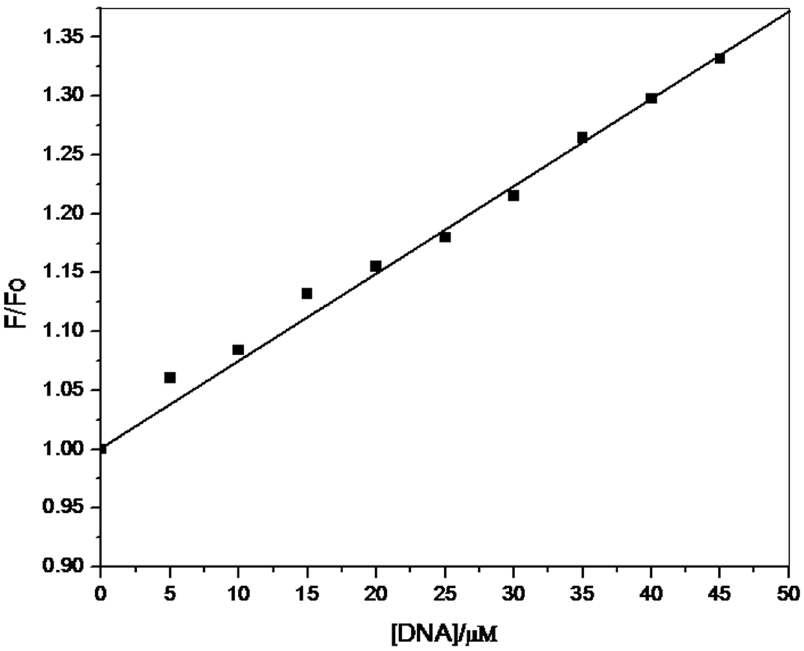
Figure 3. Stern-Volmer plot for interaction of 6MP with CT-DNA. The fluorescent intensity was found to be directly proportional to DNA concentration. Binding constant of 7.8 6 10 3 M 2 1 was obtained from the slope.